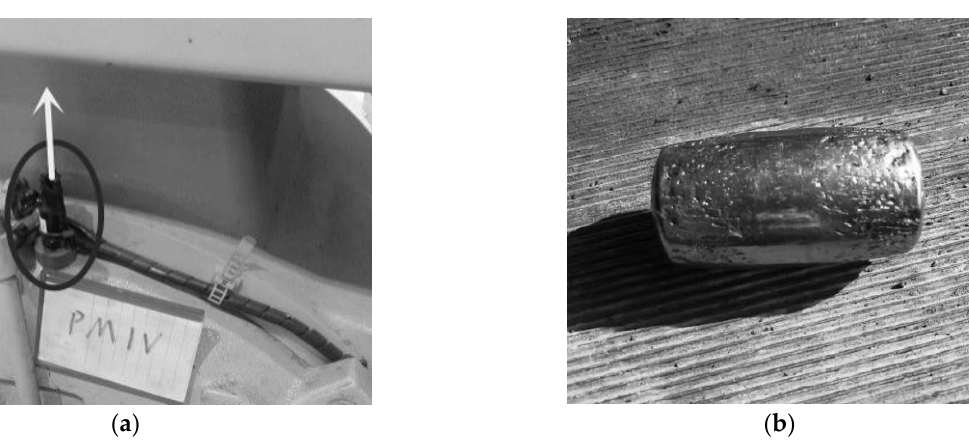
Figure 6. Gear box of lifting mechanism of port crane. ( a ) Drive gear set for installation. ( b ) Gear bearing.